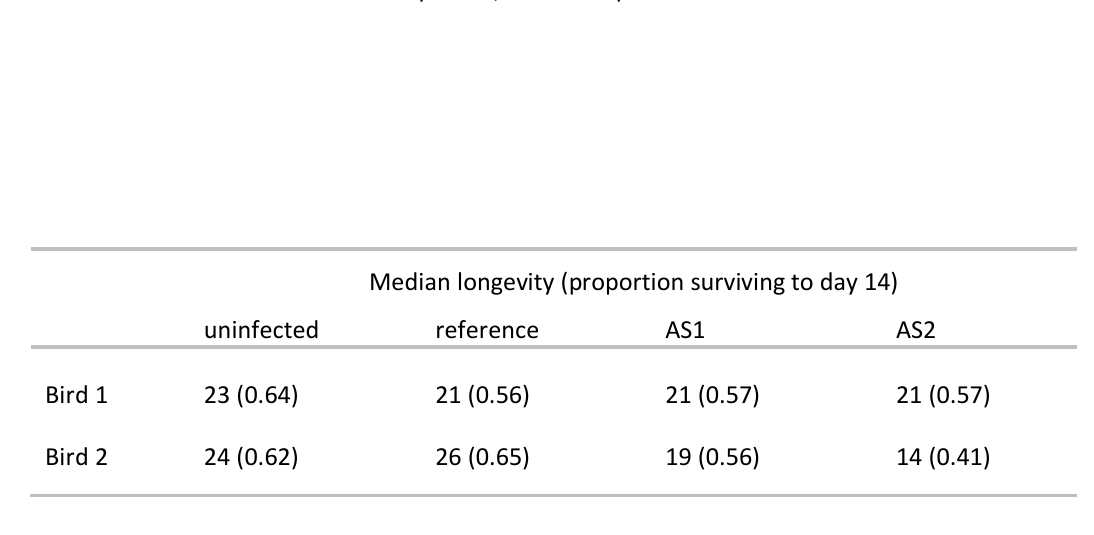
ST4: Median mosquito longevity and, in parenthesis, proportion of mosquitoes surviving to day 14 (peak sporozoite production) for uninfected mosquitoes, and mosquitoes infected with the reference or AS- selected lines. Data are presented separately for each